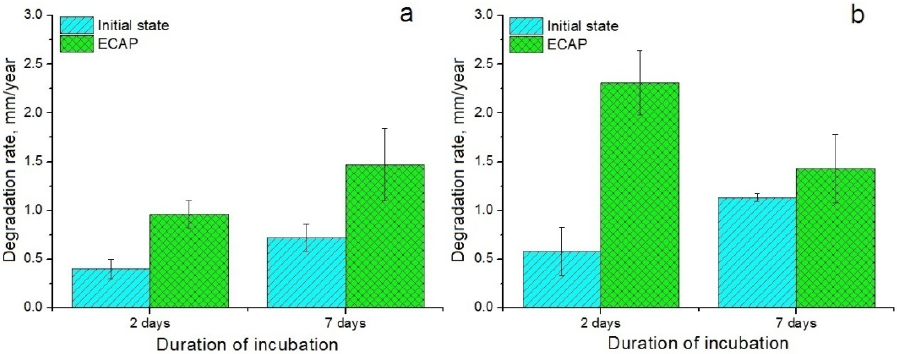
Figure 5. Degradation rate of Mg-2.0%Ag ( a ) and Mg-4.0%Ag ( b ) samples in the initial state and after ECAP processing (regime 2).